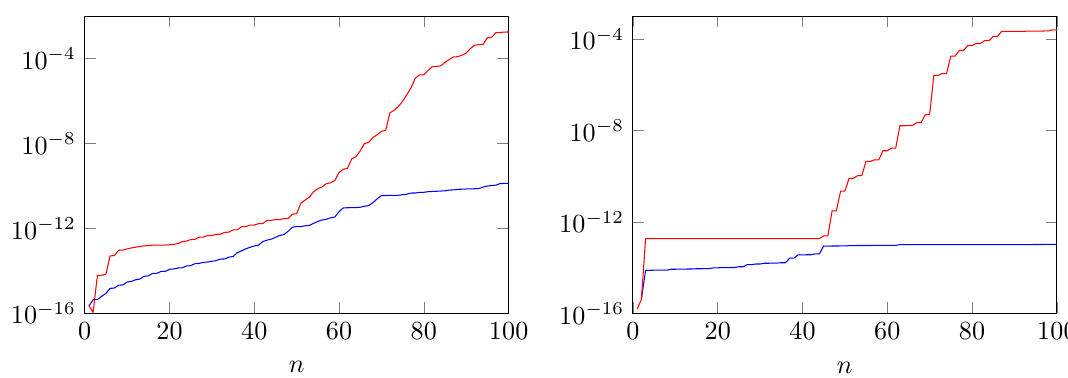
Figure 3: Biorthogonality and projection error, respectively left and right, for a shifted unitary matrix ( U + ωI ) ∈ C 200×200 , with ω = 0.1 and same starting vectors. Two-term recurrence relation in blue and four-term recurrence relation in